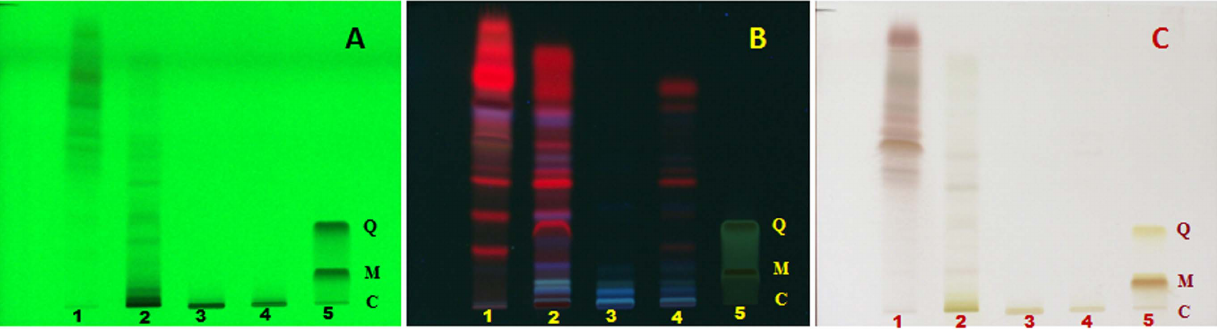
Figure 7. HPTLC fingerprint of extracts of G.glauca flower. (1) Petroleum ether extract, (2) Ethyl acetate extract, (3) Methanol extract, (4) Ethanol extract (70% v/v) at (A) 254 nm, (B) 366 nm and (C) 600 nm. Standards used are quercetin (Q), myricetin (M) and catechin (C) in lane 5.